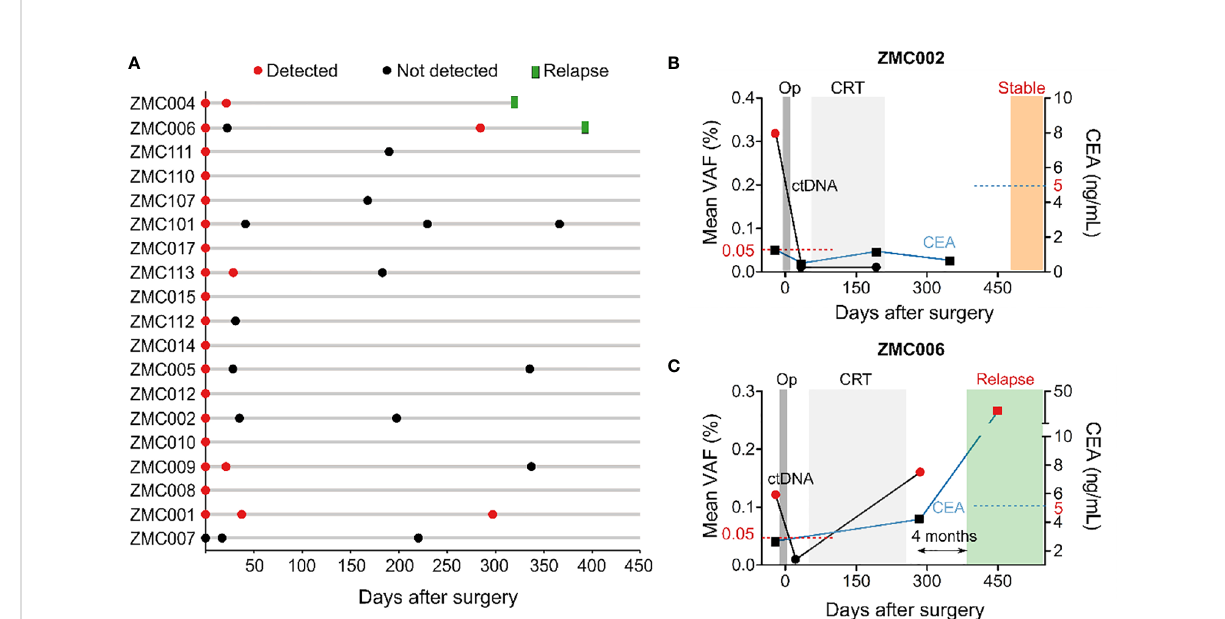
FIGURE 5 Longitudinal monitoring of ctDNA and clinical outcomes of patients. (A) Swimmer plot depicting ctDNA results over time and incidence of relapse in 19 patients that had been followed up for at least 16 months. This was an interim analysis as the study is on-going. (B, C) Longitudinal plot showing the mean VAF of ctDNA, CEA level, treatment and clinical status over time of patients ZMC002 and ZMC006. Molecular relapse detection was 4 months earlier than clinically diagnosed relapse in patient ZMC006. CEA level was still normal at the time point when ctDNA was found positive. Op, operation, CRT,